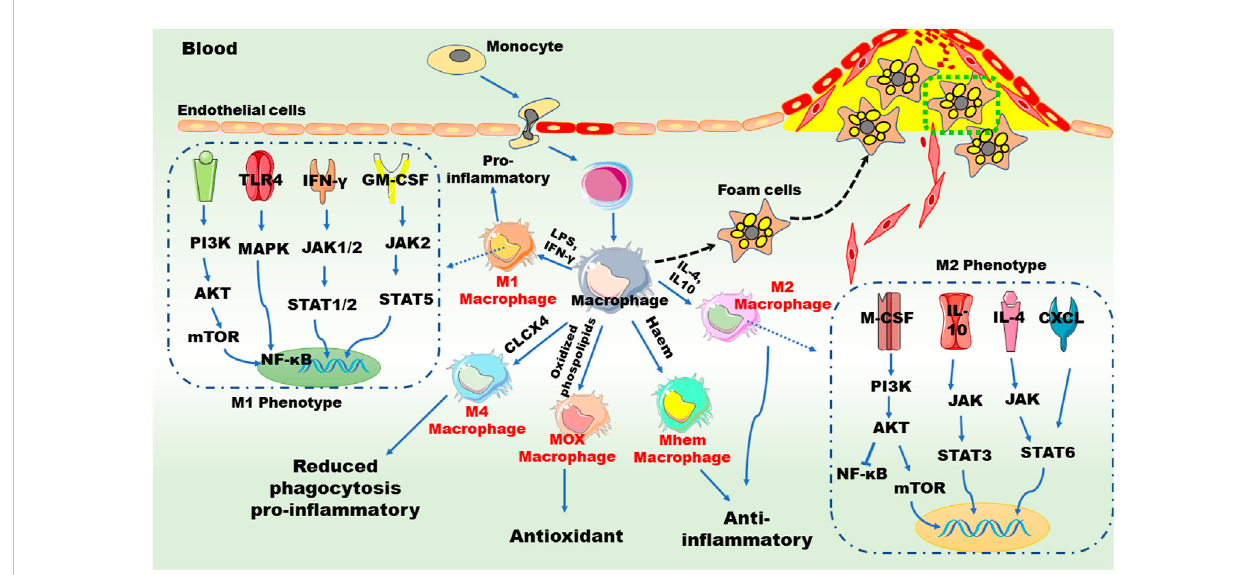
FIGURE 2 Macrophages and in fl ammation in atherogenesis. Chronic in fl ammation promotes the accumulation of monocytes on the surface of endothelial cells of the aorta and induces monocytes transition and transformation. Granulocyte-macrophage colony-stimulating factor and macrophage colony- stimulating factor mediate the polarization of M1 and M2 macrophages, respectively. The polarization of M1 macrophages is promoted by pro- in fl ammatory factors, such as tumor necrosis factor (TNF), interleukin (IL)-6, monocyte chemoattractant protein 1, and interferon- γ (IFN- γ ), while the polarization of M2 macrophages is mediated by anti-in fl ammatory factors such as IL-4, IL-10, and transforming growth factor β . Different signaling pathways are involved in these phenotype shifts. Furthermore, monocyte/macrophage can be differentiated into Mox, M4 and Mhem subtypes upon distinct stimuli. AKT: serine/threonine-protein kinases; CXCL: chemokine (C-X-C motif) ligand; GM-CSF: granulocyte-macrophage colony stimulating factor; JAK: janus kinase; LPS, lipopolysaccharide; MAPK: mitogen activated protein kinases; M-CSF: macrophage colony stimulating factor;